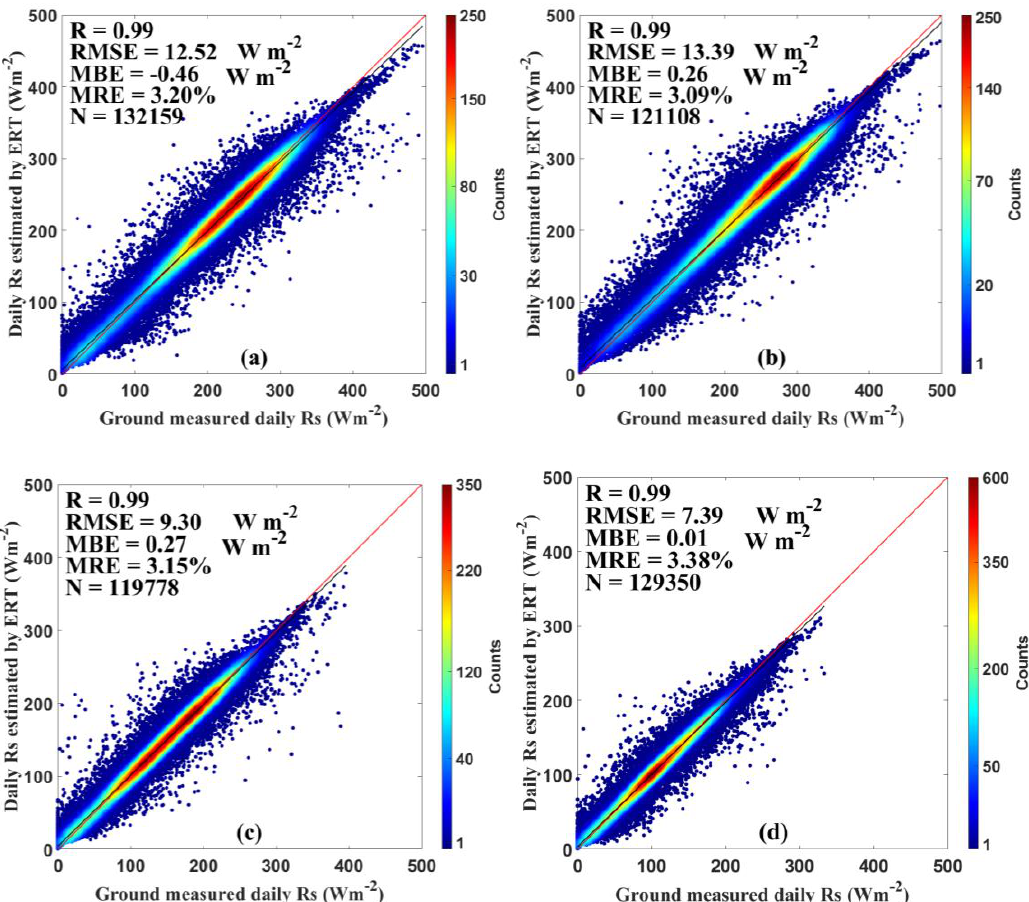
Figure 6. Evaluation results of the ERT-based model in ( a ) spring (March to May), ( b ) summer (June to August), ( c ) autumn (September to November), and ( d ) winter (December to February) over China during 2000–2015.